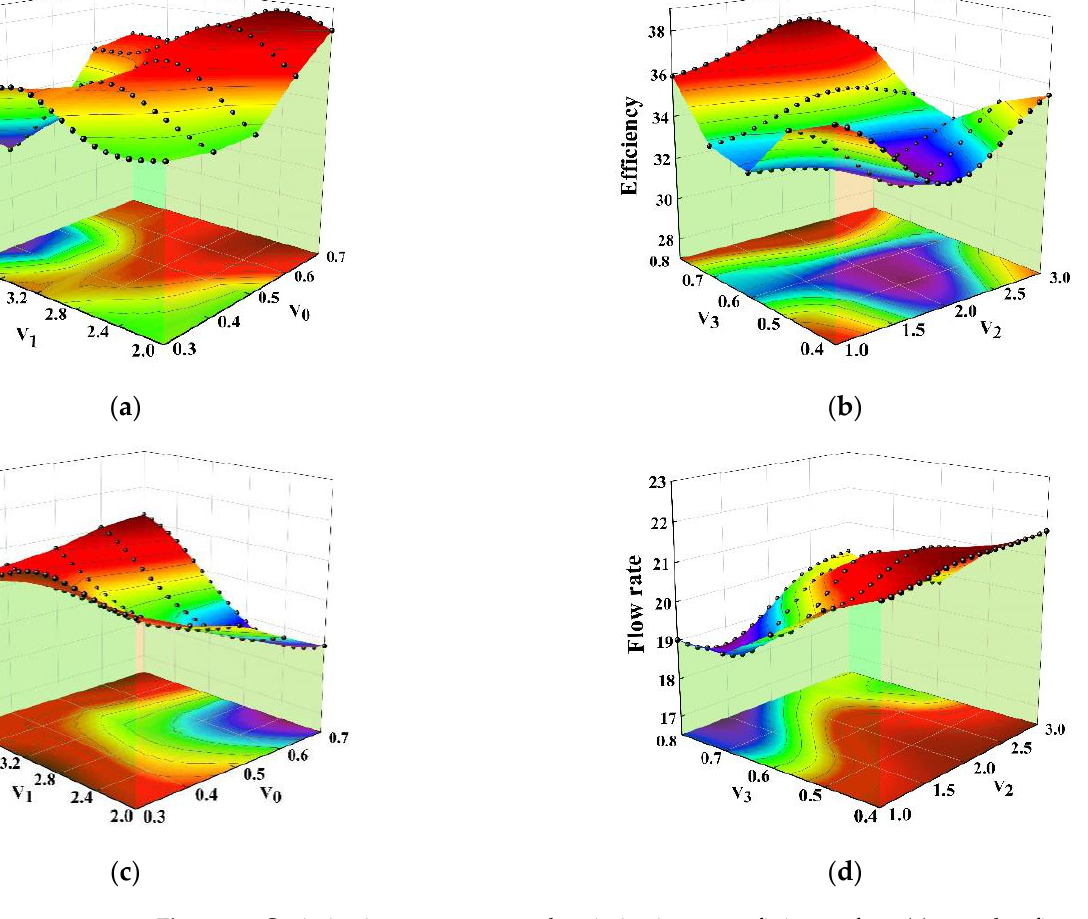
Figure 11. Optimization parameters and optimization target fitting surface. ( a ) v 0 and v 1 fit surfaces with efficiency (%). ( b ) v 2 and v 3 Fitting surfaces with efficiency (%). ( c ) v 0 and v 1 fit surfaces with flow rate (m 3 /min). ( d ) v 2 and v 3 fit surfaces with flow rate (m 3 /min).